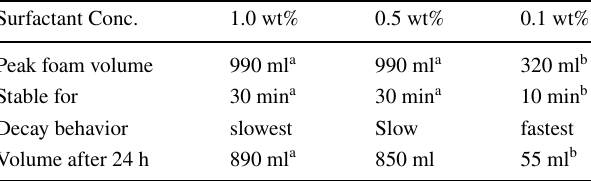
Table 9 Summary of bulk foam stability test results for the effect of surfactant concentration